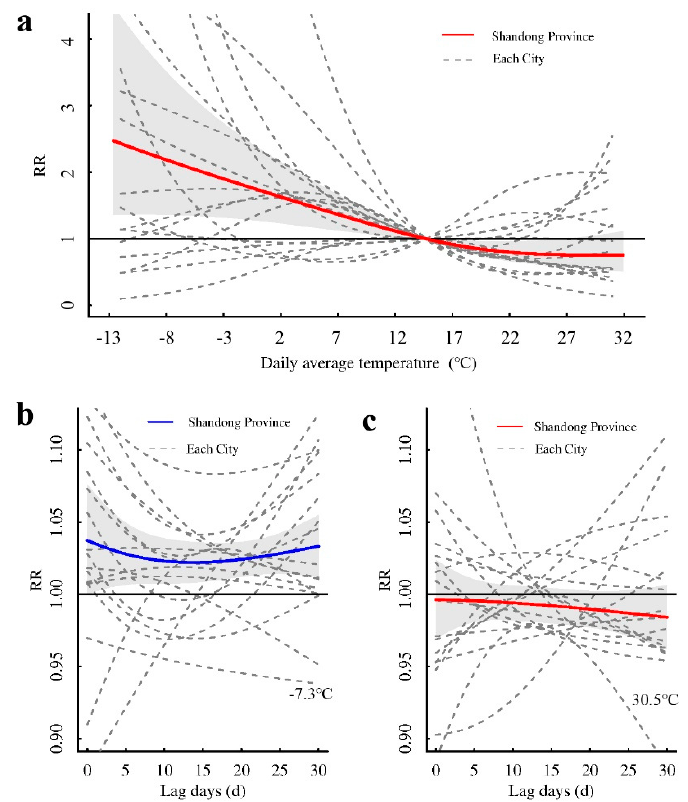
Figure 4. The effect of temperature on mumps. ( a ) The cumulative RR of temperature on mumps in Shandong Province and other cities with a 30-day lag. ( b,c ) represent the effects of low and high temperatures, respectively, in Shandong Province and 17 cities on mumps under different lag times.